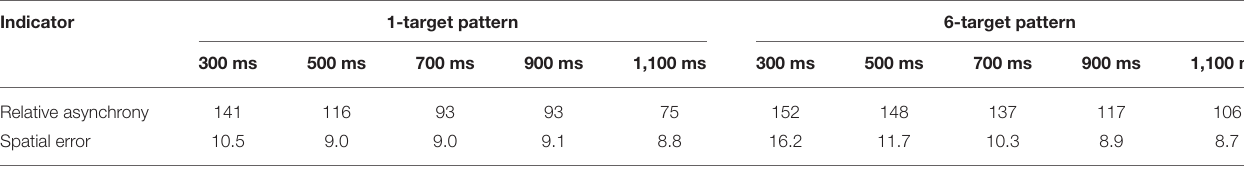
TABLE 2 | Synchronization and spatial indicators for Study 2.